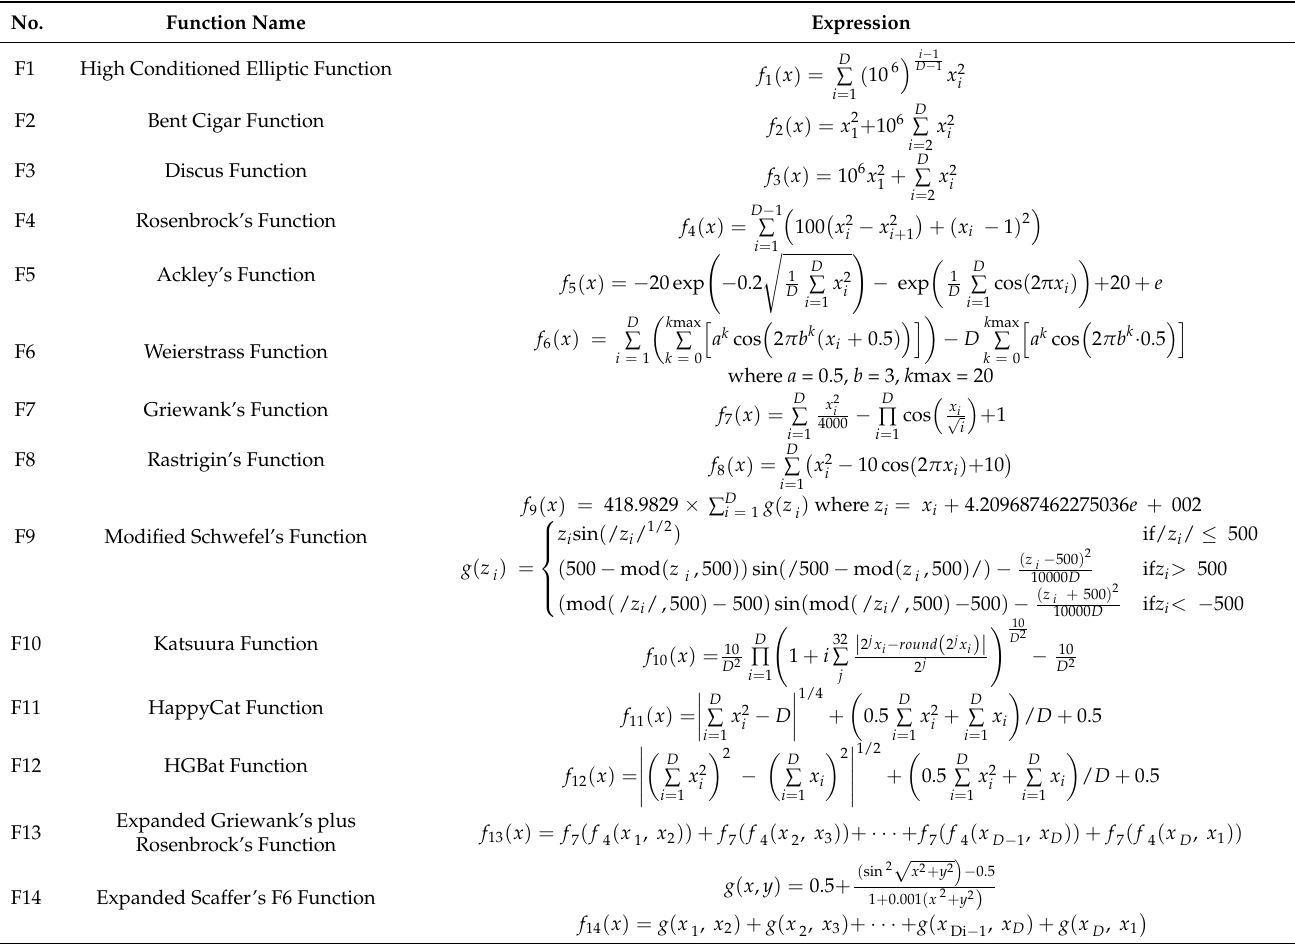
Table A2. Definitions of the basic functions in CEC